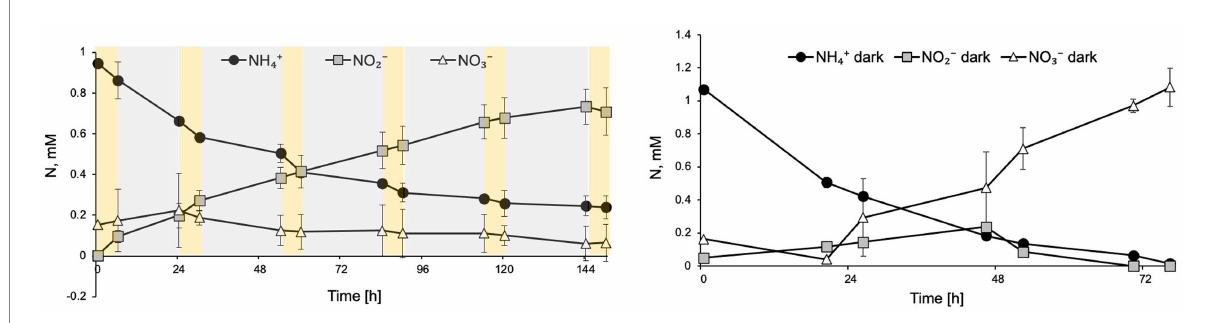
FIGURE 5 Diurnal light exposure of N. inopinata at 6 h light/18 h dark regimen caused ammonia oxidation delay, nitrite accumulation, and interruption of nitrate production. (A) Nitrogen concentration for N-NH 4+ , N-NO 2 − , and N-NO 3 − are shown for diurnal N. inopinata exposure; (B) Nitrogen concentration for N-NH 4+ , N-NO 2 − , and N-NO 3 − for N. inopinata cultures kept in the dark. Data are presented as the mean and standard error of triplicate